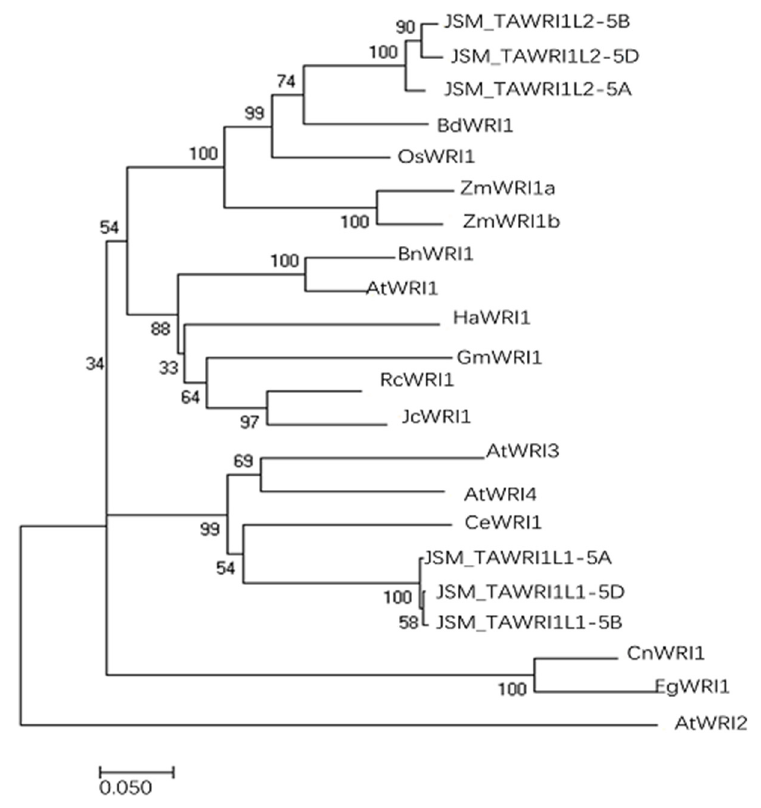
Figure 1. The evolutionary tree of TaWRI1Ls and WRI1s of other plants. The bootstrap parameter was